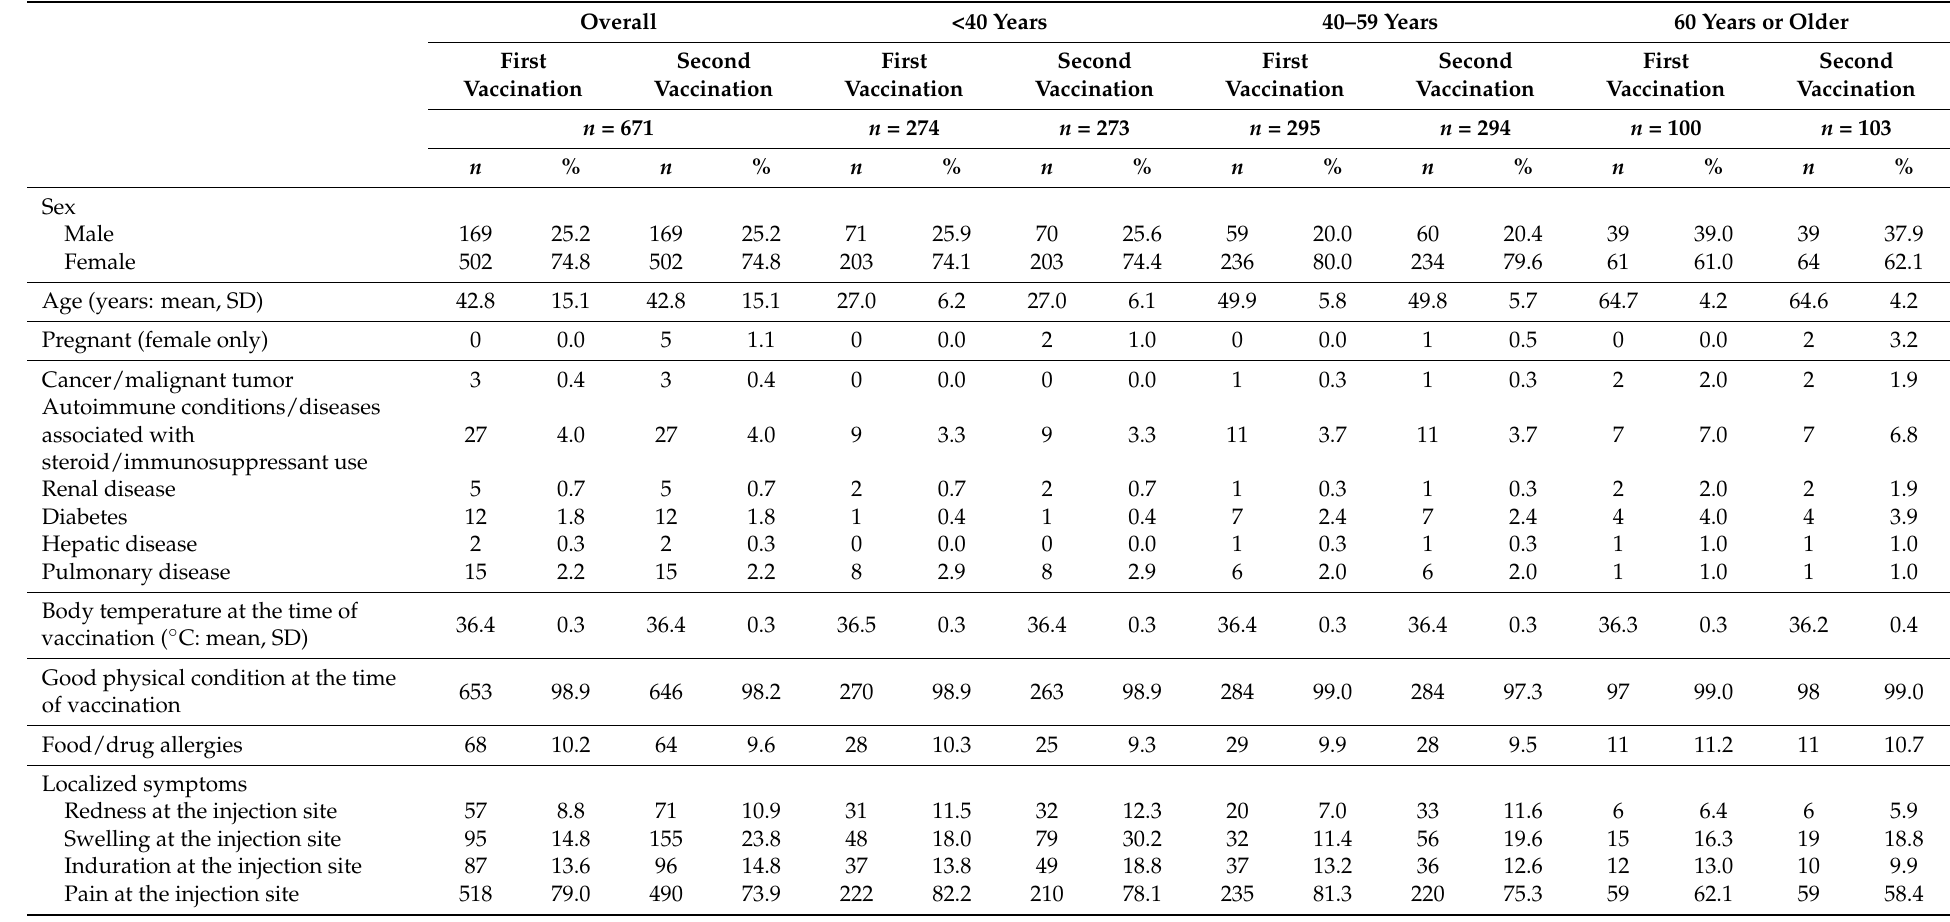
Table 1. Participants’ background characteristics and symptoms in the 2 weeks after vaccination according to